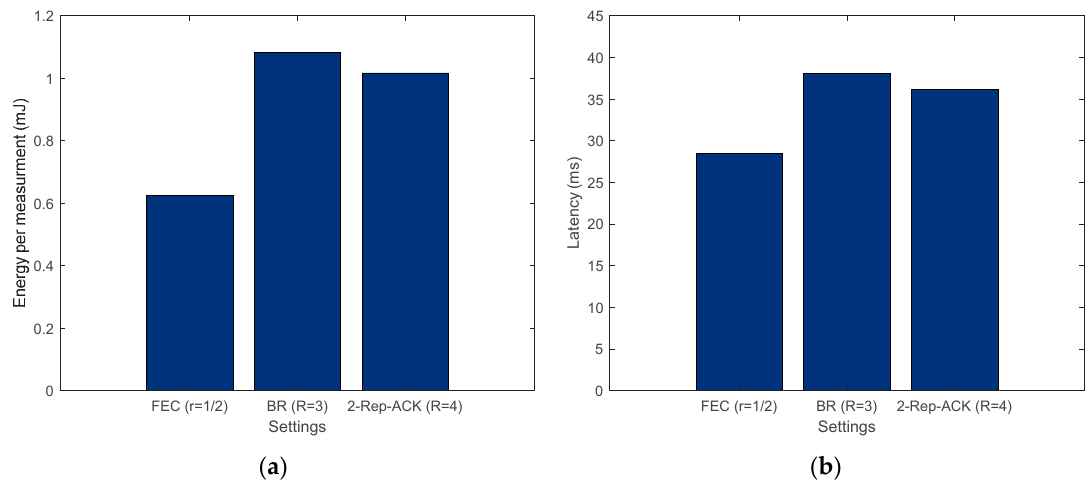
Figure 24. ( a ) Energy consumption per measurement and ( b ) system latency for 99% reliability target.